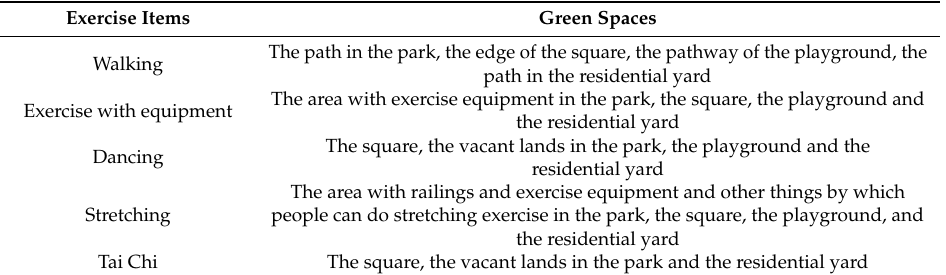
Table 8. Exercise item support of di ff erent spatial forms of green spaces.